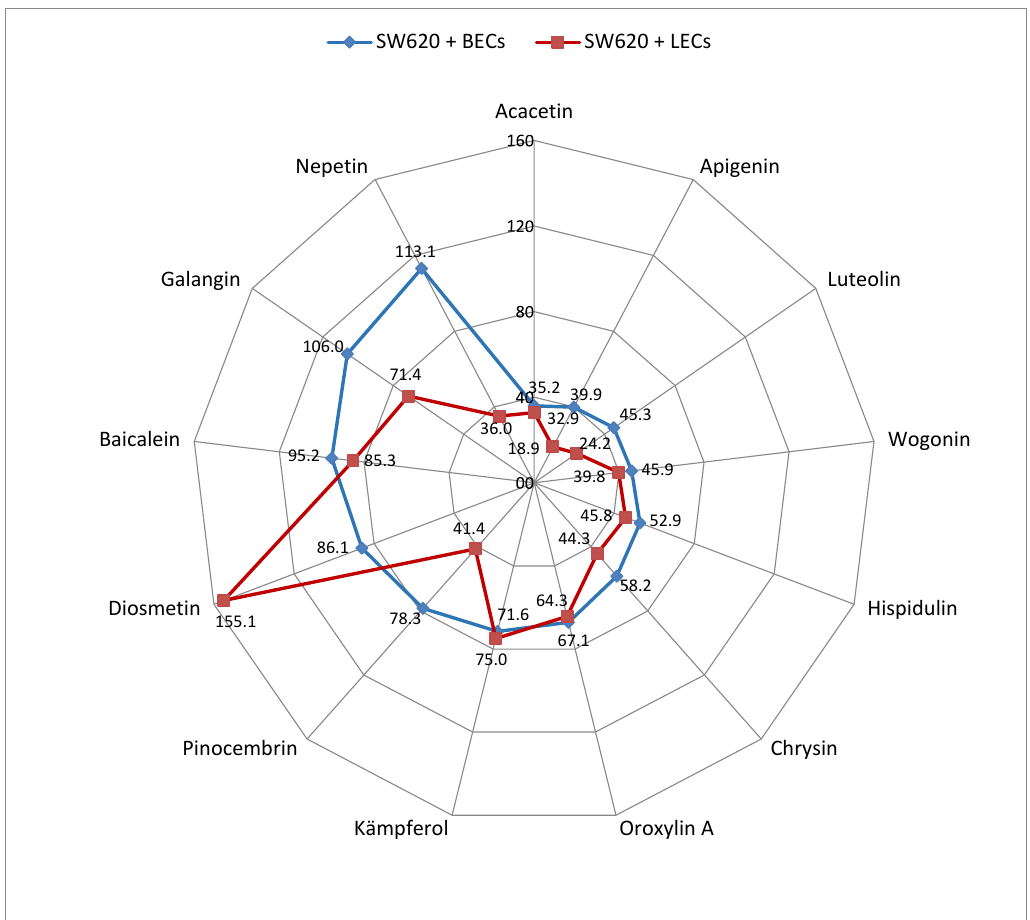
Figure 3. Inhibition of of CCID formation (IC 50 ) values; µM) by studied flavonoids in the SW620/BEC (blue line) and the SW620/LEC model (red line) with at least one of them < 90 µM. The results are the mean pooled from 3 independent experiments performed in 5-fold measurements ( n = 3).